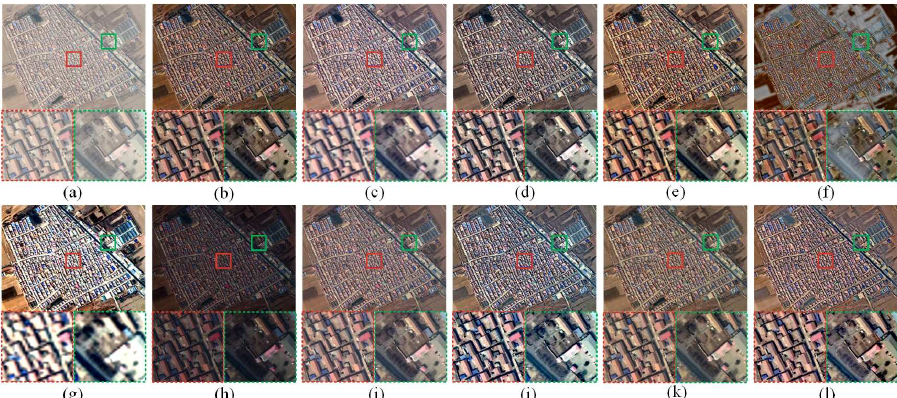
Figure 8. Dehazing example 2 of a remote sensing image from a real hazy scene: ( a ) Original; ( b ) DCP; ( c ) GPR; ( d ) AMP; ( e ) DEFADE; ( f ) WCD; ( g ) RRO; ( h ) MOF; ( i ) CAP; ( j ) HLM; ( k ) DN; ( l ) Proposed. Two partially enlarged images marked in red and green dotted frames correspond to the regions surrounded by red and green frames in the dehazed